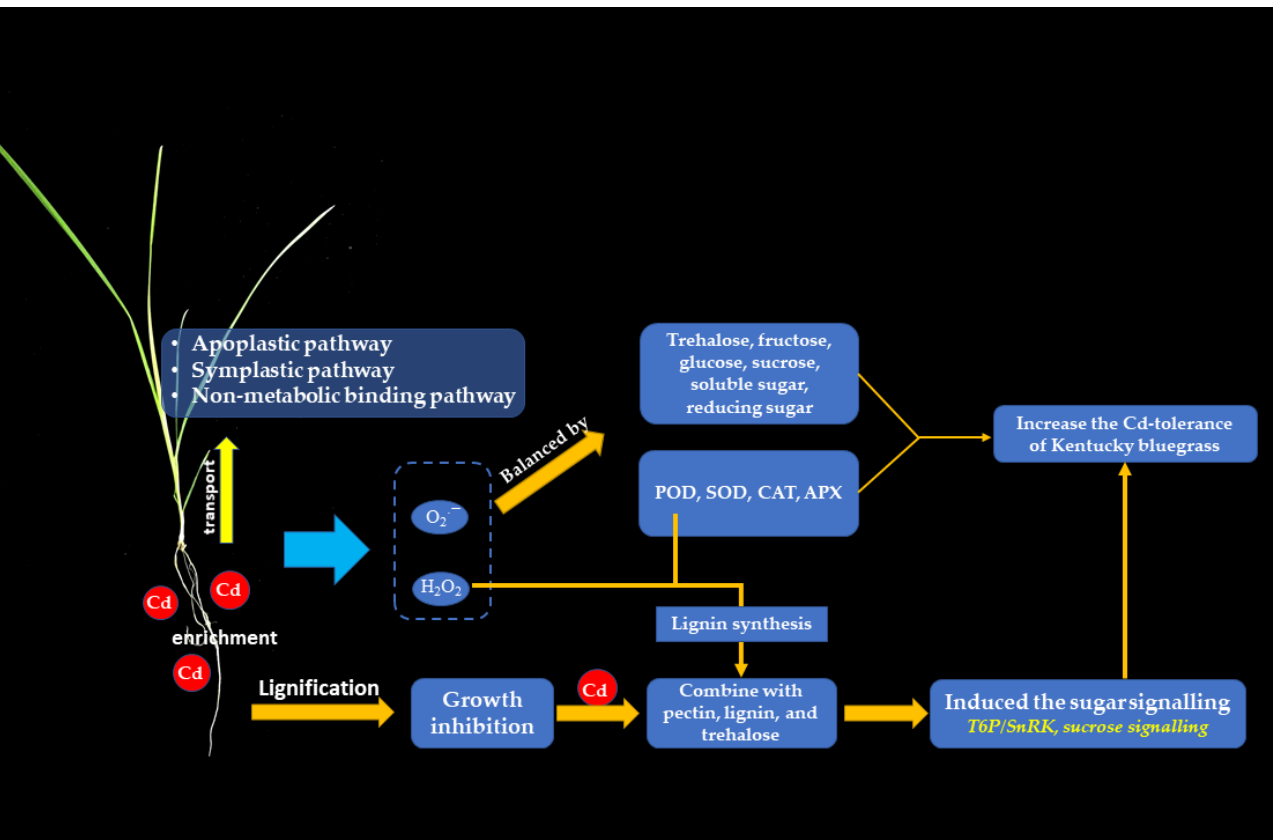
Figure 6. Hypothetical model of the events occurring in the Kentucky bluegrass under cadmium stress.